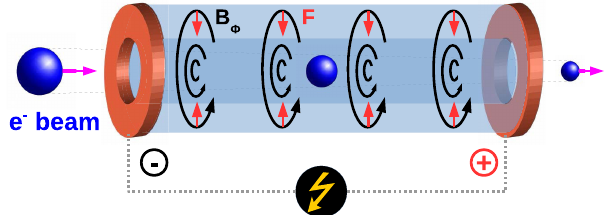
FIG. 3. Representation of the active-plasma lens working mechanism. A discharge current is applied to the capillary through two symmetric electrodes. The current generates an azimuthal magnetic field ( B ϕ ) that produces a focusing force ( F ) for the incoming electron beam.